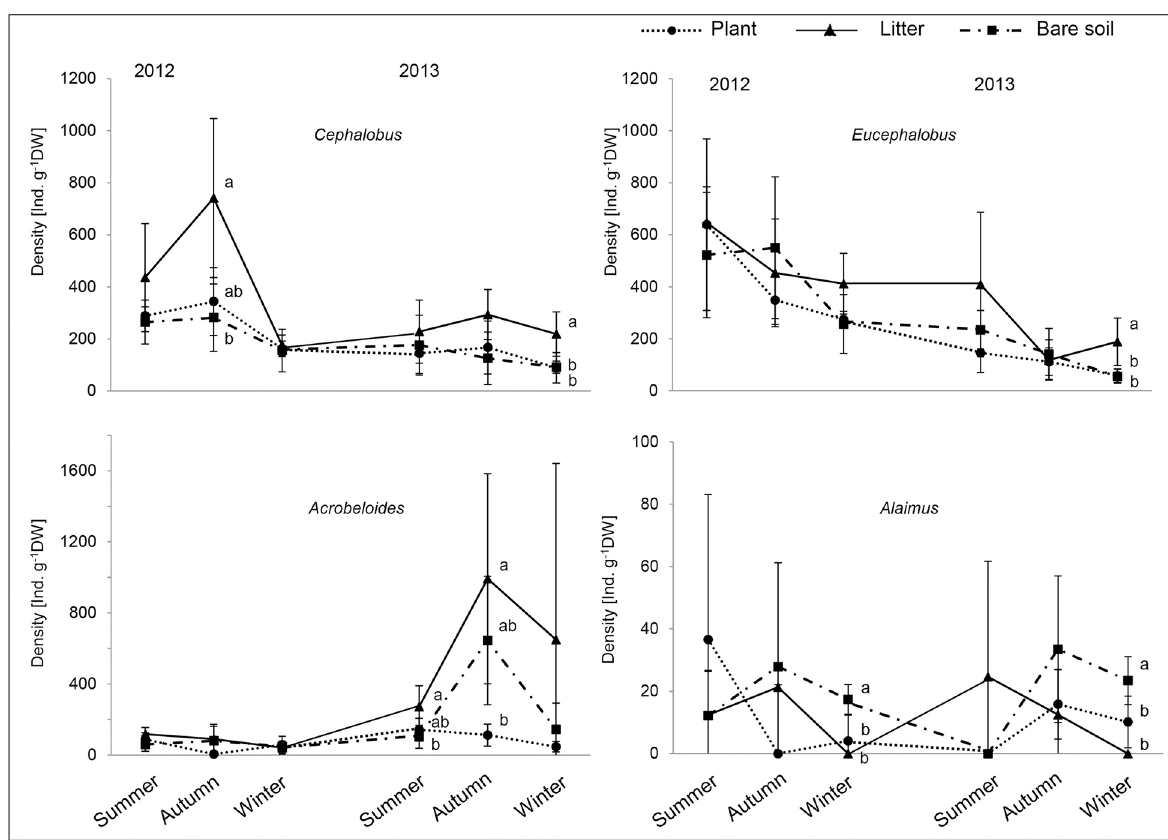
Fig 3. Occurrenceof the bacterial-feeding taxa Cephalobus , Eucephalobus , Acrobeloides and Alaimus in soil cropped with maize (plant), amended with maize shoot litter (litter) or bare soil. Abundance (individuals100 g -1 dry weight soil ± SD) is given in topsoil (0–10 cm), rooted zone (40–40cm), and root free zone (60–70cm) in the years 2012and 2013. Values within a samplingdate with the same or no letters are not significantly different accordingto Tukey´s HSD test at P <